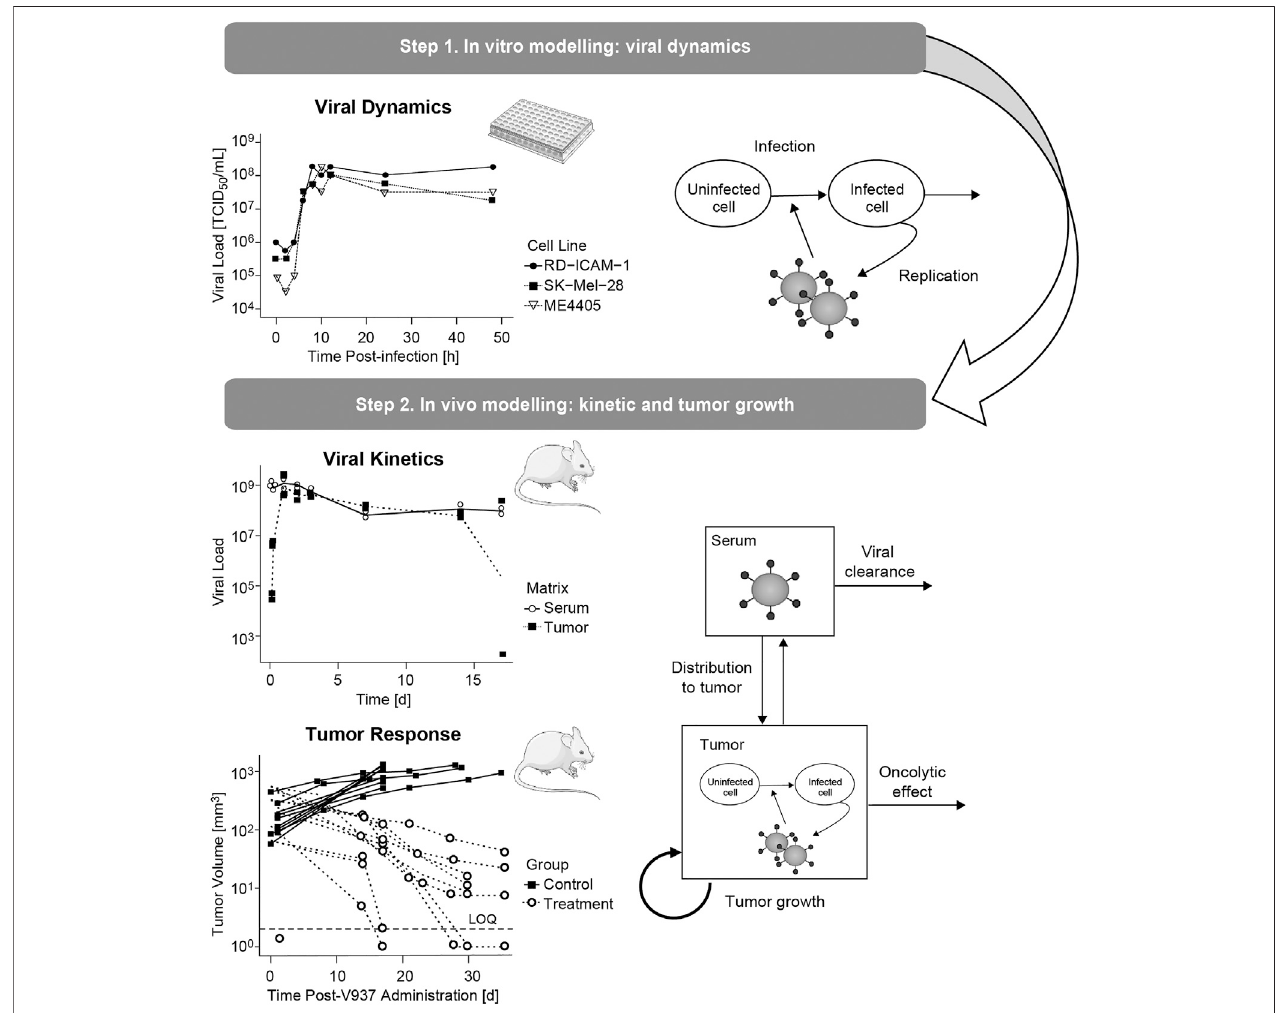
FIGURE 1 | Schematic representation of the modelling and data work fl ow, highlighting the key processes identi fi ed at each